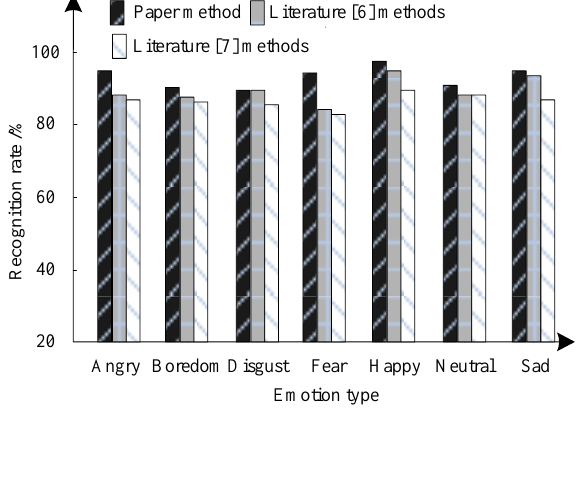
Fig 5. Comparison results of emotion